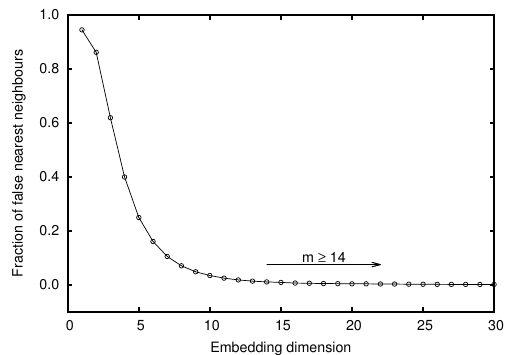
Fig. 2. The Space time separation plot for the time series for m =14 Figure 3. (a) The autocorrelation function of wind speed data. Fig. 3. (a) The autocorrelation function of wind speed data. (b) Mu- and τ =85 . Each point in the plot represents a pair of points on the (b) Mutual information of the wind speed data as a function of delay tual information of the wind speed data as a function of delay ( τ ). trajectory with their relative separation in time along the horizontal ( τ ). axis and separation in space along the vertical axis. The diurnal variations are evident in this figure.